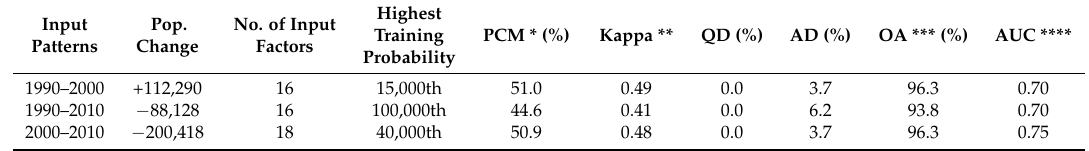
Table 3. LTM statistical output for all models and scenarios trained.